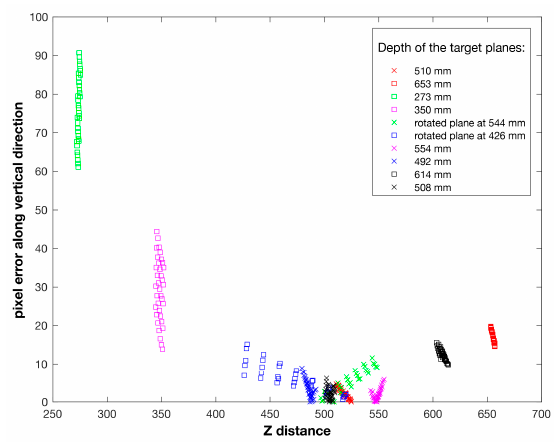
Figure 8. Vertical monoscopic disparities.